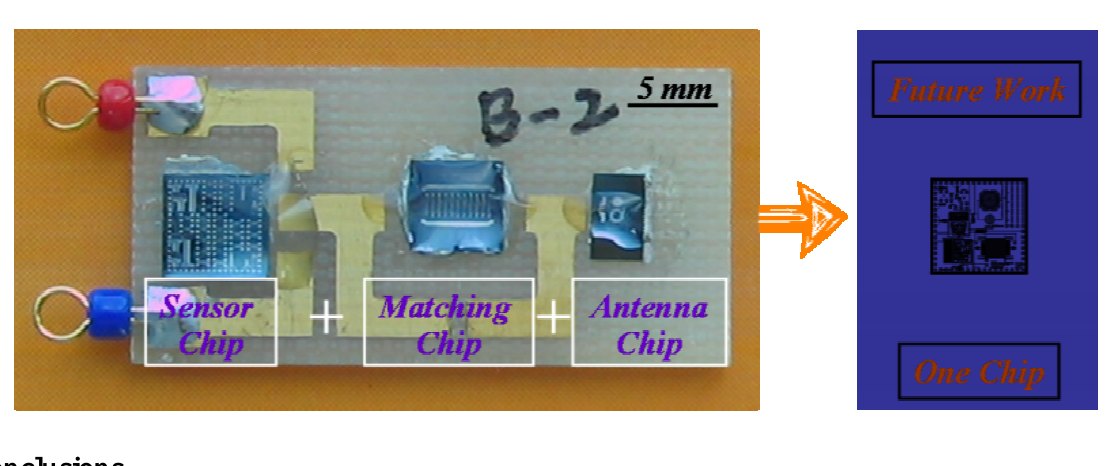
Figure 15. The multi-chip packaged smart microsensor and the concept diagram of one